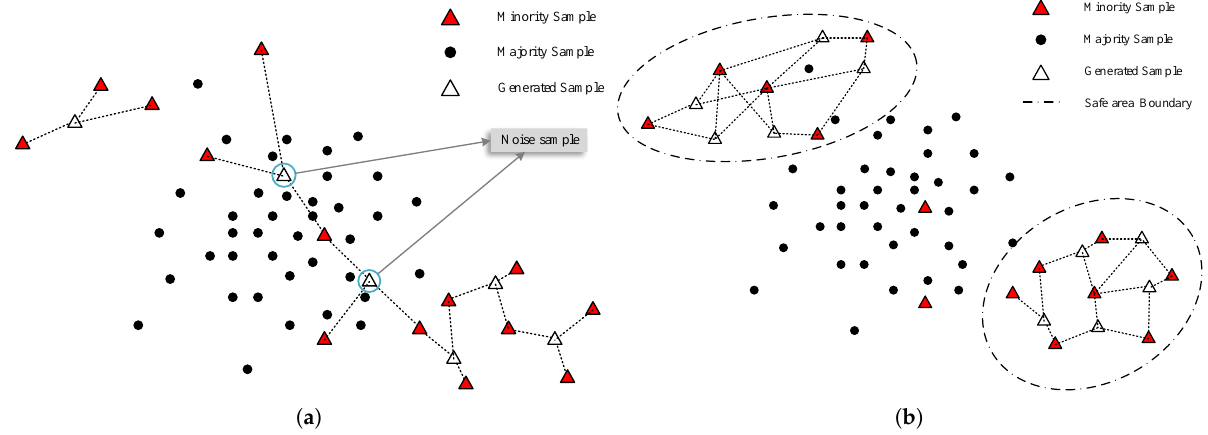
Figure 2. ( a ) SMOTE may generate noise sample (k = 2). ( b ) fuzzy clustering synthetic minority oversampling technique algorithm (FC-SMOTE) synthesizes new minority samples in safe